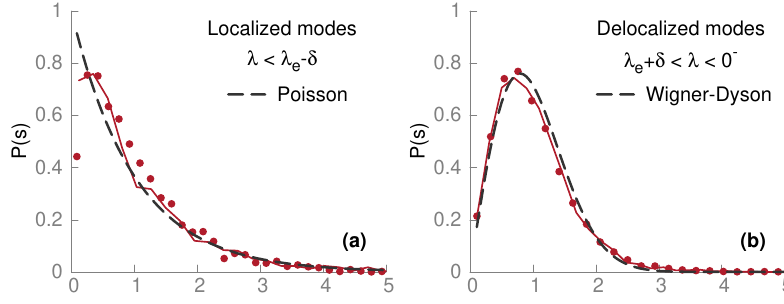
Figure 7: Level spacing statistics at T = 0.35 for (a) localized and (b) delocalized modes in the ternary mixture model. The distribution P ( s ) of level spacings s is computed in the indicated portion of eigenvalues, with δ = 2. Full lines and symbols indicate results for W -minimizations ( N = 3000) and EF optimizations ( N = 1000), respectively. The dashed line indicates a Poisson distribution in (a) and a Wigner- Dyson distribution in (b), see text for